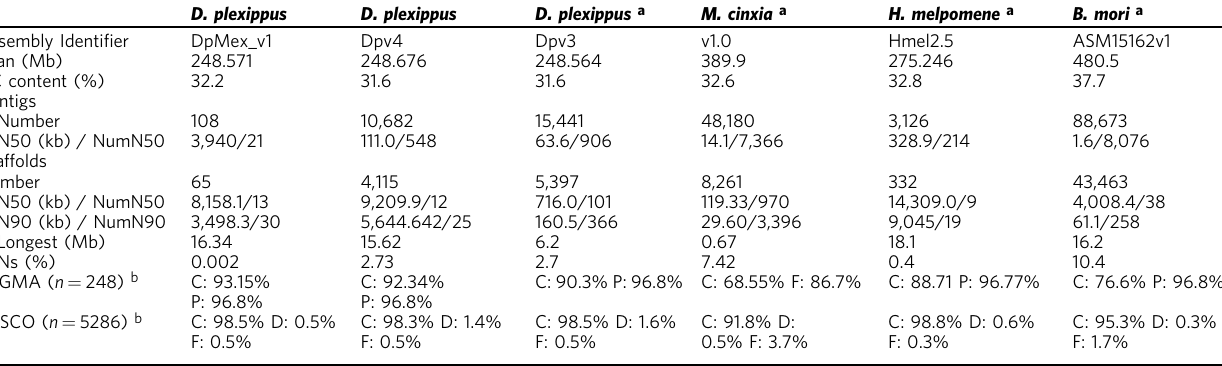
Table 1 Salient features of the D. plexippus genome assembly obtained here compared to other relevant